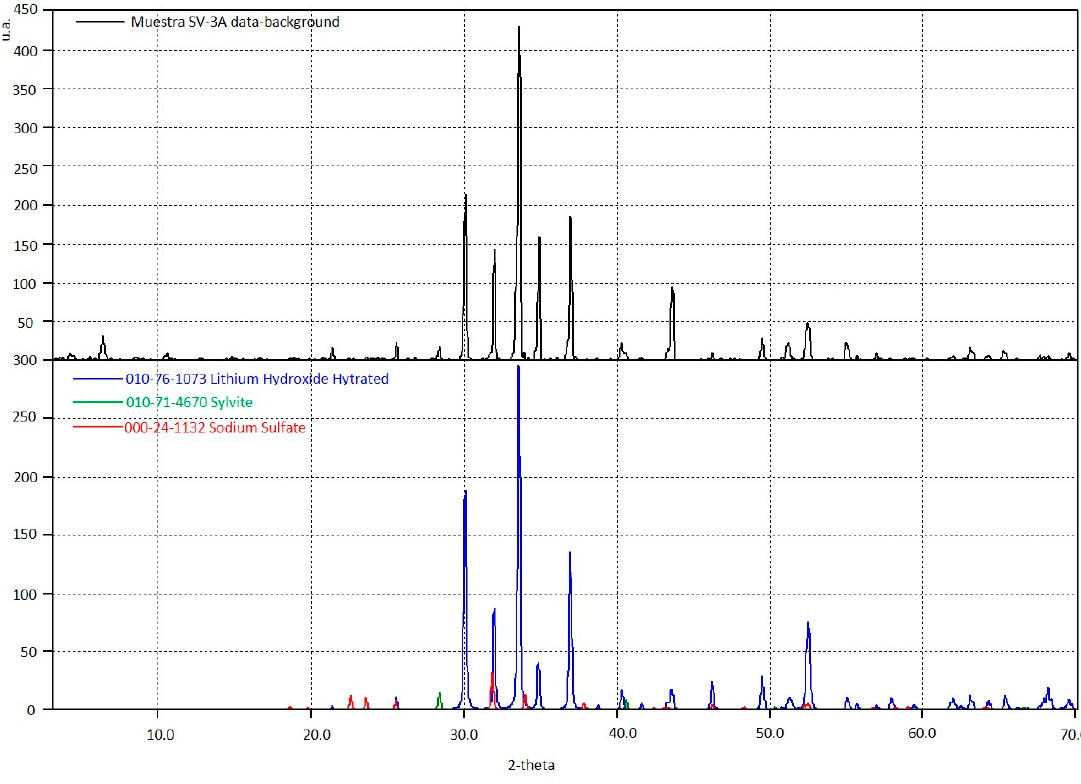
Figure 12. Di ff raction pattern of the crystals obtained in the experiment Figure 12. Diffraction pattern of the crystals obtained in the experiment 2.